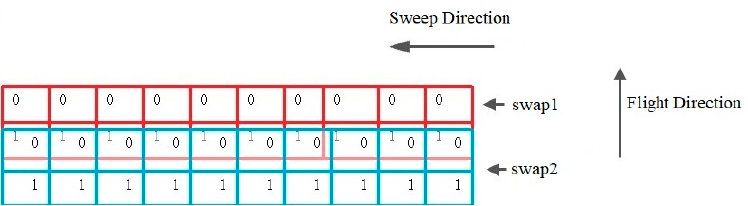
Figure 3. Flights with VisionMap A3. Number 0 represents images captured by lenses 0, number 1 represents images captured by lenses 1.